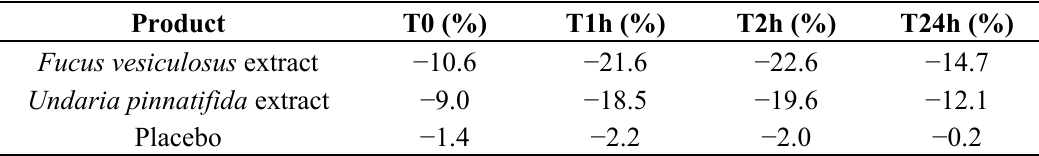
Table 9. Erythema after application of placebo or active cream, as compared to control (Study Scheme 1); n = 25 (percent change of mean vs. control).